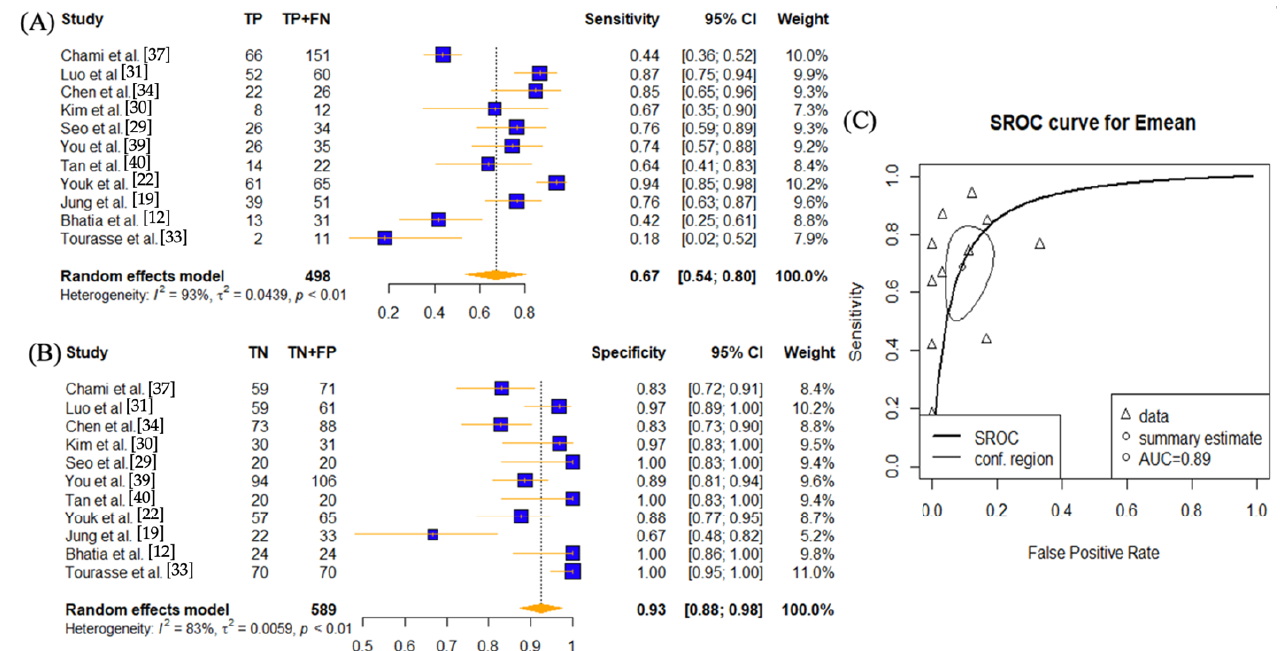
Figure 3. Sensitivity and specificity forest plots and overall accuracy results of E mean . (( A – C ) Reported sensitivity and specificity values for E mean values per selected study with AUC value on SROC curve for the analysis of E mean . Forest plots for pooled sensitivities and specificities are displayed as diamonds in the graphs for E mean ( A , B ). The SROC curve indicates the summary estimates in circles (( C ) for E mean ). Triangles represent included study with dotted lines representing the confidence interval and solid line for the SROC. AUC value is displayed (in the legend). E mean —average tissue stiffness SWE parameter; AUC—area under the curve; SROC—summary receiver operating characteristic.